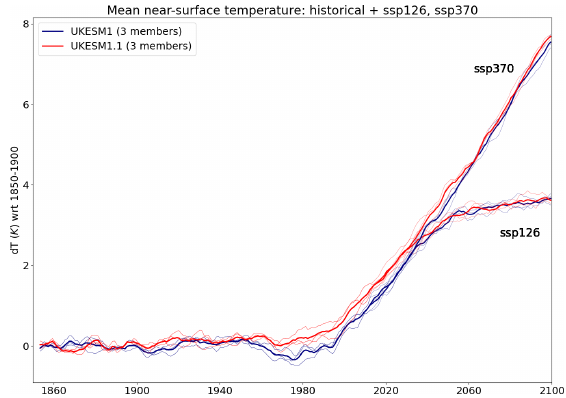
Figure 19. Global mean near-surface air temperature anomaly rela- tive to 1850–1900 mean for the historical period and SSP1–2.6 and SSP3–7.0 for UKESM1 (blue) and UKESM1.1 (red). Thick lines are the respective three-member ensemble means and the thin lines are the individual ensemble